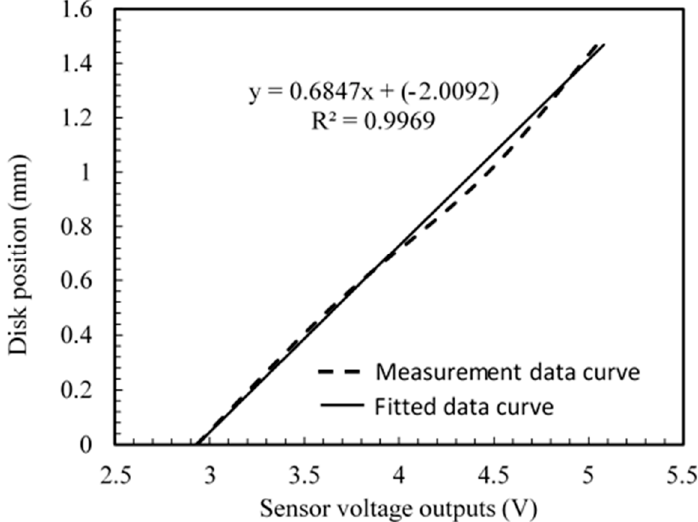
Figure 10. Calibration equation of the inductive displacement sensor from the measurements taken using a voltmeter at the sensor output with respect to the measurements taken using the micrometer as the disk displaces. Input voltage to the sensor is 10 Volts . Table 2. Repeated measurements of disk displacement by inductive sensor and a micrometer taken at a same occasion. Input voltage to the sensor is 15 Volts.